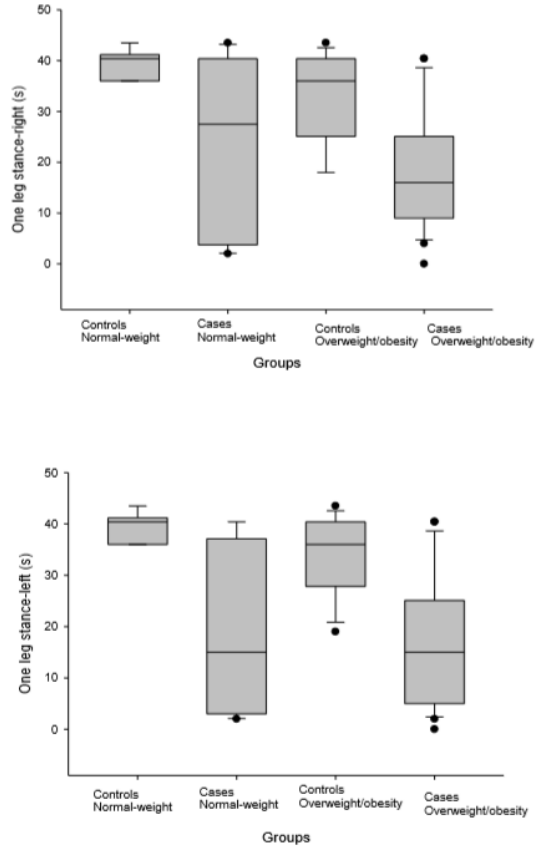
Figure 2. Levels of static balance measured with One leg stance test in cases of women with fibromyalgia and healthy controls grouped by their body mass index (normal-weight versus overweight / obese). In the box plots, the boundary of the box closest to zero indicates the 25th percentile, the black line within the box marks the median, and the boundary of the box farthest from zero indicates the 75th percentile. Whiskers above and below the box indicate the 10th and 90th percentiles.